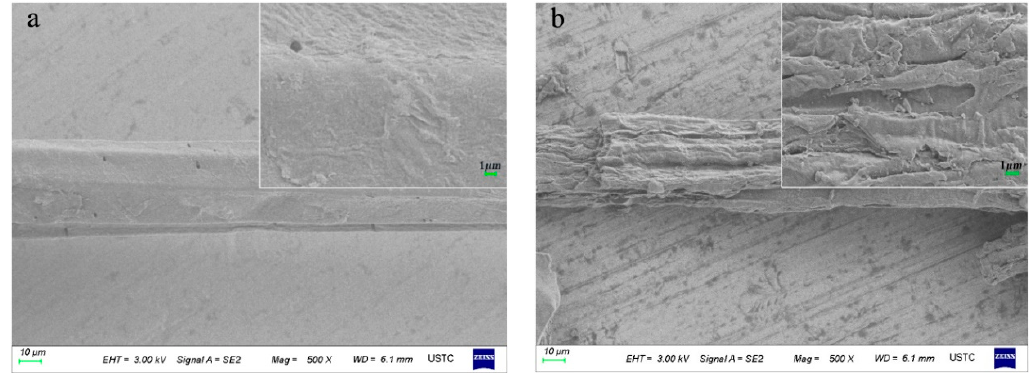
Figure 1. SEM images for pumpkin vine cellulose (PVK) ( a ) and a novel phosphonic acid and acrylic acid functionalized pumpkin vine based cellulose adsorbent (PVKAP) ( b ).